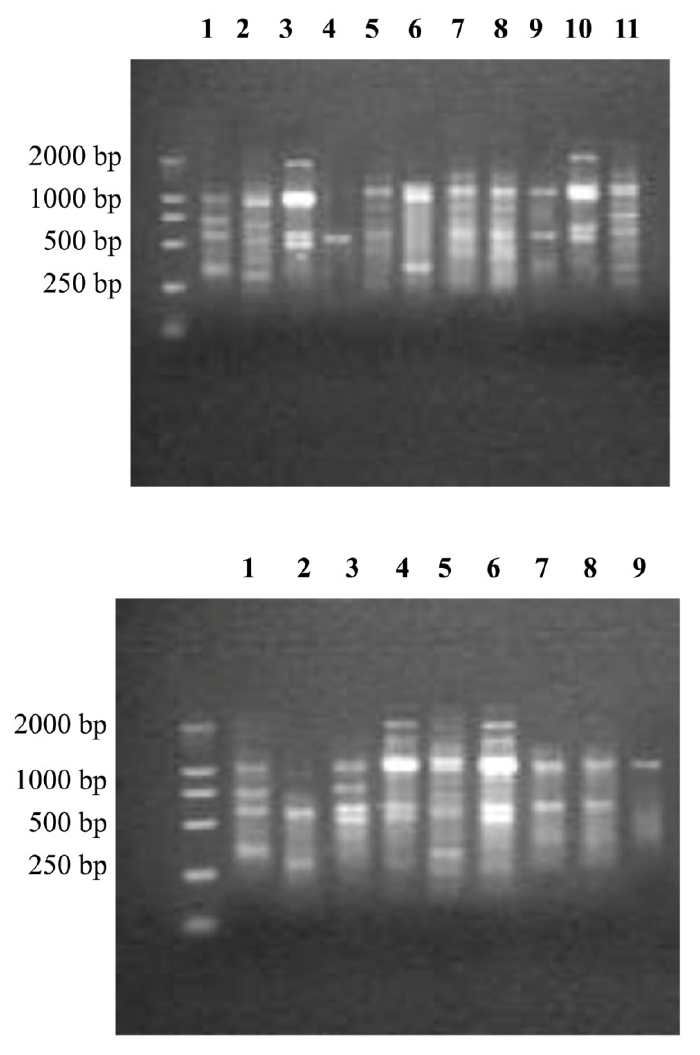
Figure 6. The genotypes of S. mutans from children with S-ECC ( A ) and caries-free ( B ) children. From 1 to 5 genotypes were detected in the ECC and caries-free groups, but the genotypes differed between the two